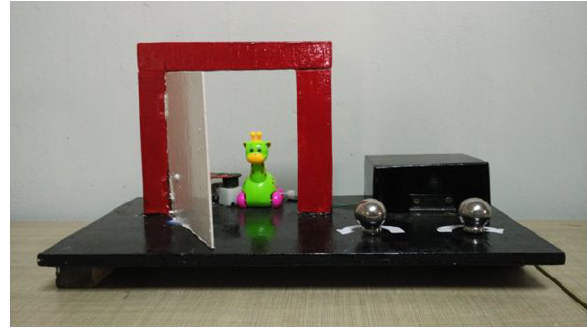
Figure 1: Mechatronic door training